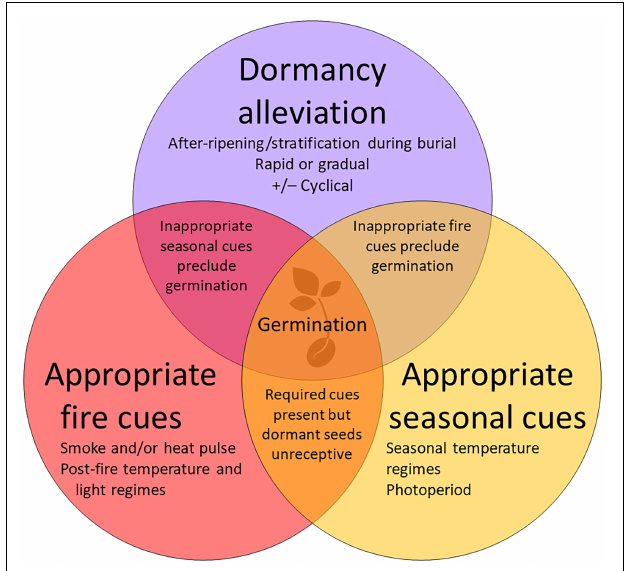
FIGURE 1 | Overlapping conditions required for germination of plant species with physiological seed dormancy in temperate fire-prone ecosystems, given adequate soil moisture. After-ripening and/or stratification are required to overcome primary dormancy in freshly dispersed, mature seeds before they become receptive to one or more fire-related cues required to stimulate germination. Some species also require particular seasonal temperature cues to germinate. The amount and duration of available soil moisture will also influence